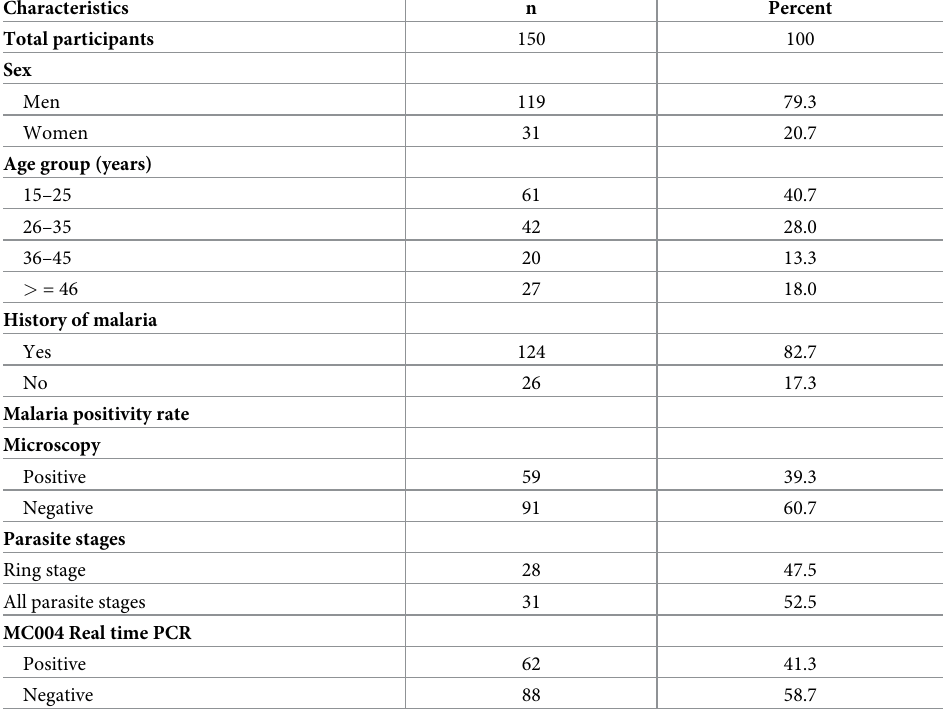
Table 1. Characteristics of the study participants.